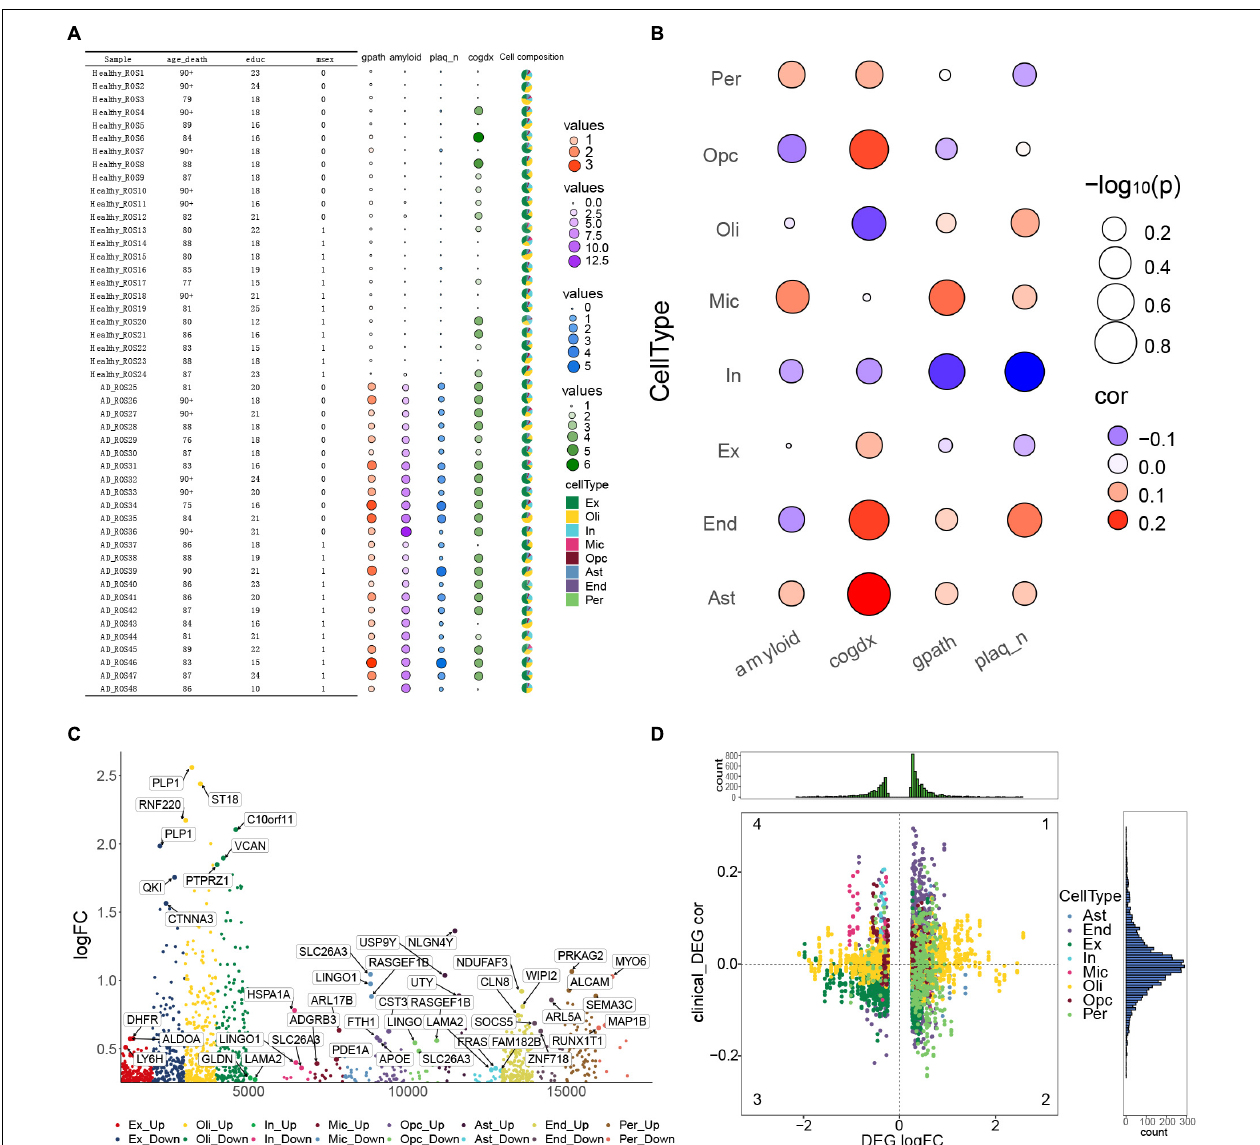
FIGURE 3 | Alzheimer’s disease pathological processes at the single-cell level. (A) Clinical data, pathological features and cell types of 48 samples were analyzed. Variables included age_death, defined as age at death; education, years of education; msex, self-reported sexual orientation; “1,” male sex; “0,” female sex; gpath, global AD pathology burden; plaq_n, neuritic plaque burden; amyloid, overall amyloid level; and cogdx, cognitive state at death. (B) Bubble heatmaps demonstrating cell abundances in individuals with strong AD pathology (gpath, amyloid, plaq_n, Cogdx). (C) Manhattan map showing genes within each cell type that were differentially expressed between the AD-pathology and no-pathology groups. (D) Quadrant diagram showing the correlation between pathological characteristics and differentially expressed genes. The ordinate represents correlation coefficient, the abscissa represents log [fold change (FC)], and color represents cell